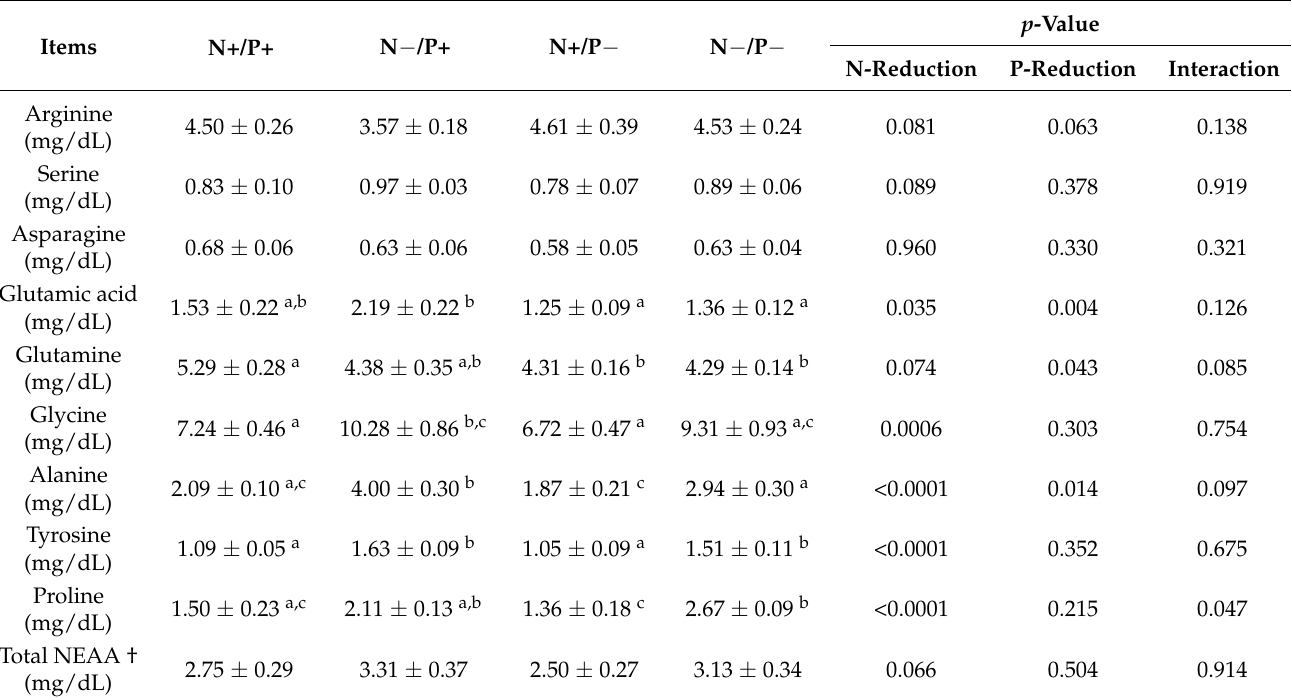
Table 5. Circulating NEAA concentration in young goats fed an N- and/or P-reduced